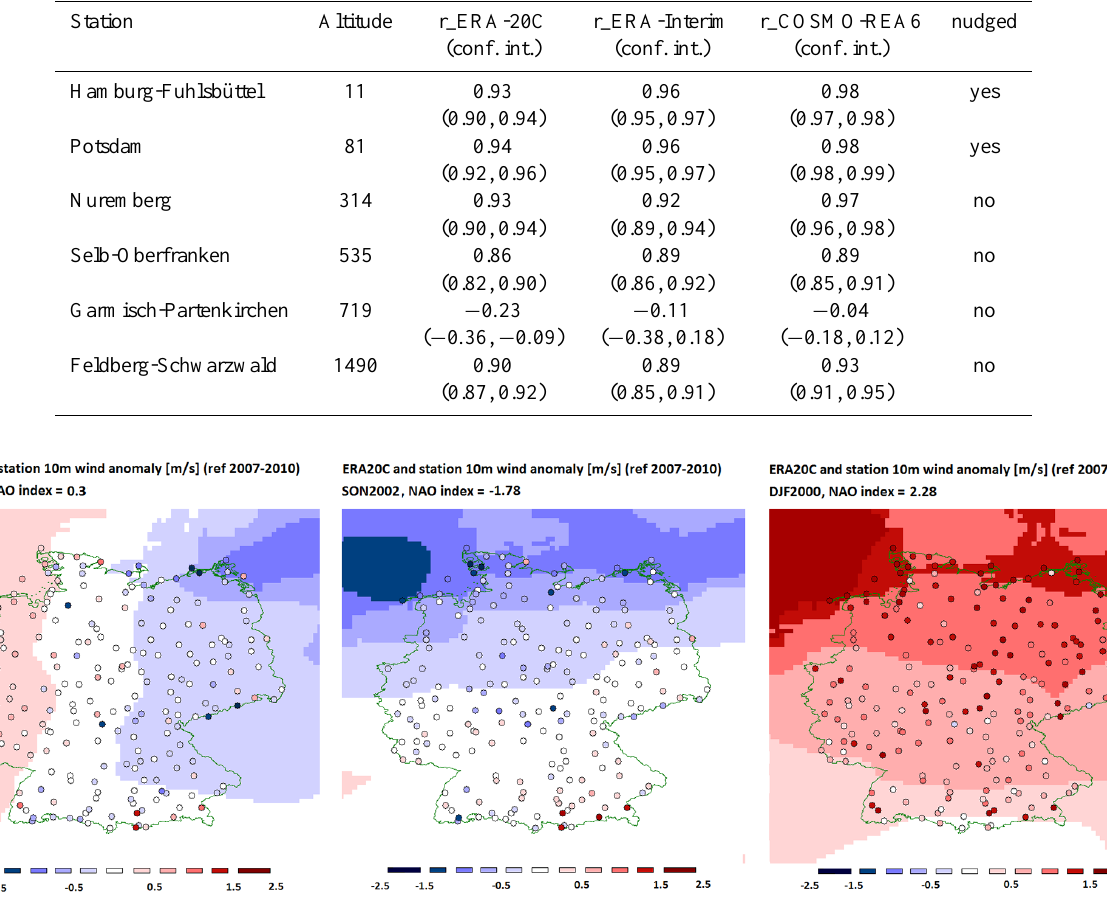
Figure 10. Seasonal anomalies of the ERA-20C 10m wind speeds compared to the reference period 2007 to 2010 for September, October, November (SON) of 2000 at neutral NAO-index (left panel), SON2002 at negative NAO-index (middle), and December, January, February (DJF) 1999/2000 at positive NAO-index